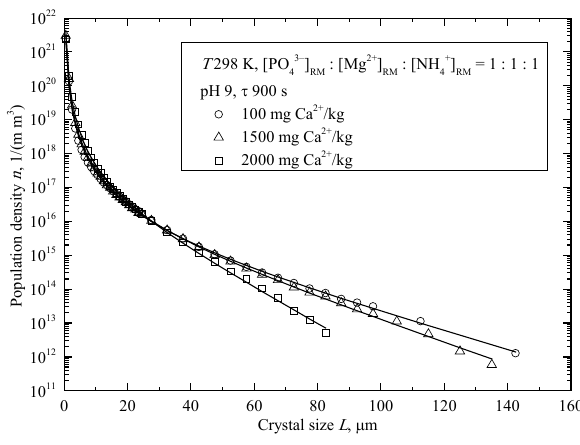
Figure 2: Comparison of population density distribution courses of struvite crystals manufactured from feeding solutions of different calcium ions concentrations (Rojkowski exponential RE SDG MSMPR kinetic model, Eq. (8) [21], tests No. 1, 3 and 4 in Table 1 and